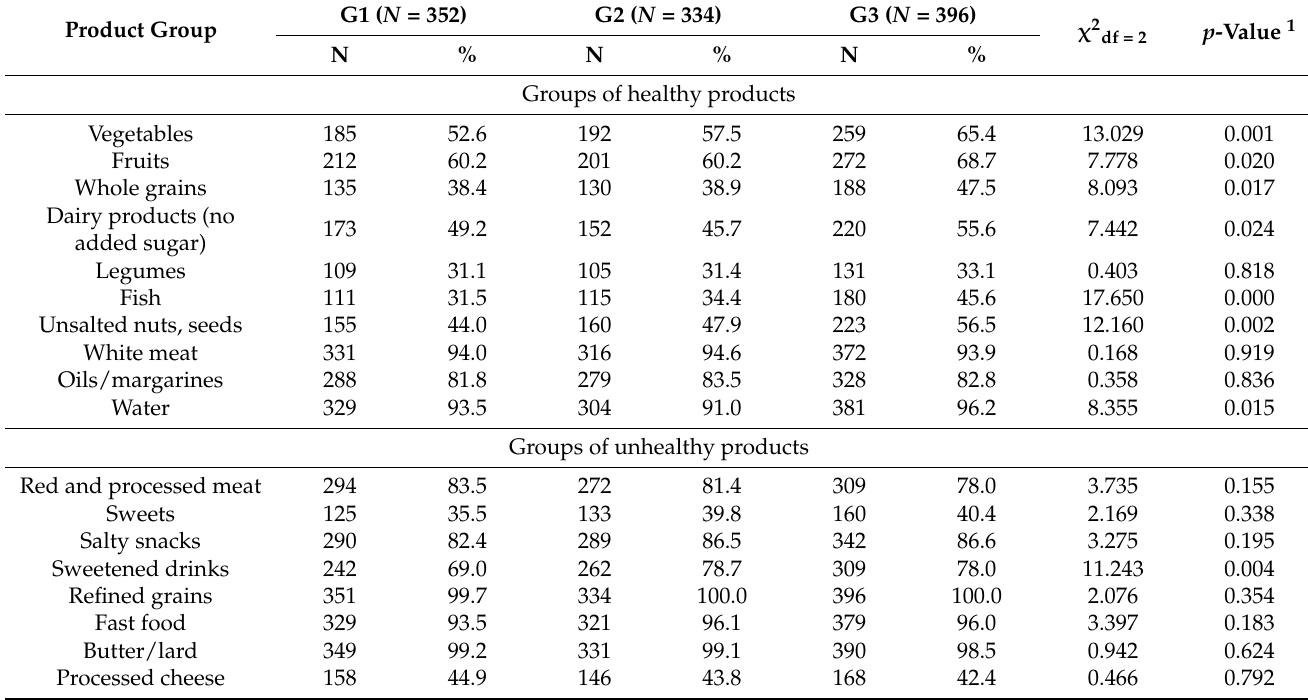
Table 5. Intergroup comparison of the frequency of consuming individual product groups with different psychological profiles.